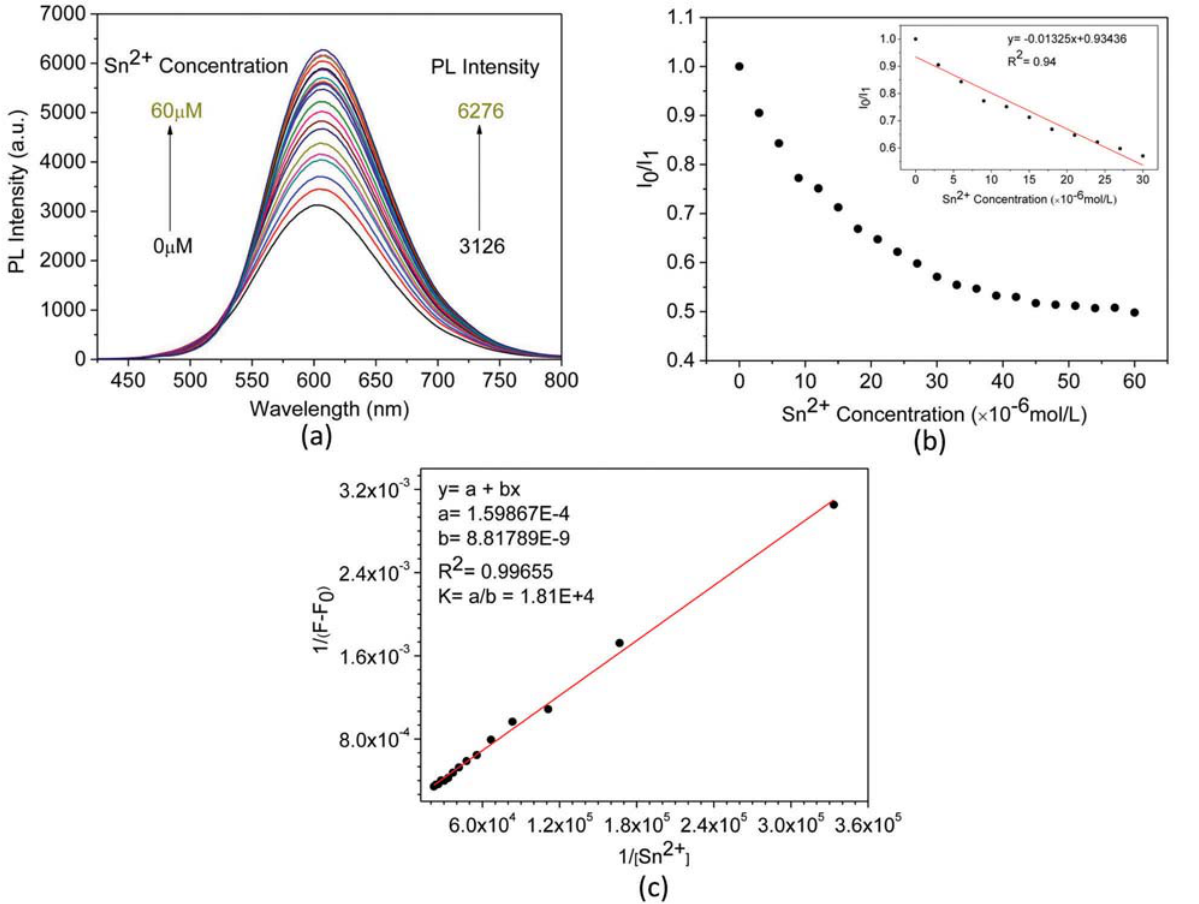
Figure 8: PL spectra of aqueous solution of (-)-PPBIPV with different concentration of Sn 2+ (a); PL titration curves of aqueous solution of (-)-PPBIPV with Sn 2+ (b); The Benesi-Hildebrand plot of aqueous solution of (-)-PPBIPV with Sn 2+